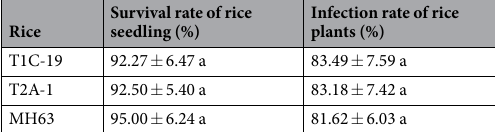
Table 1. Infection rate of transgenic rice with SRBSDV.